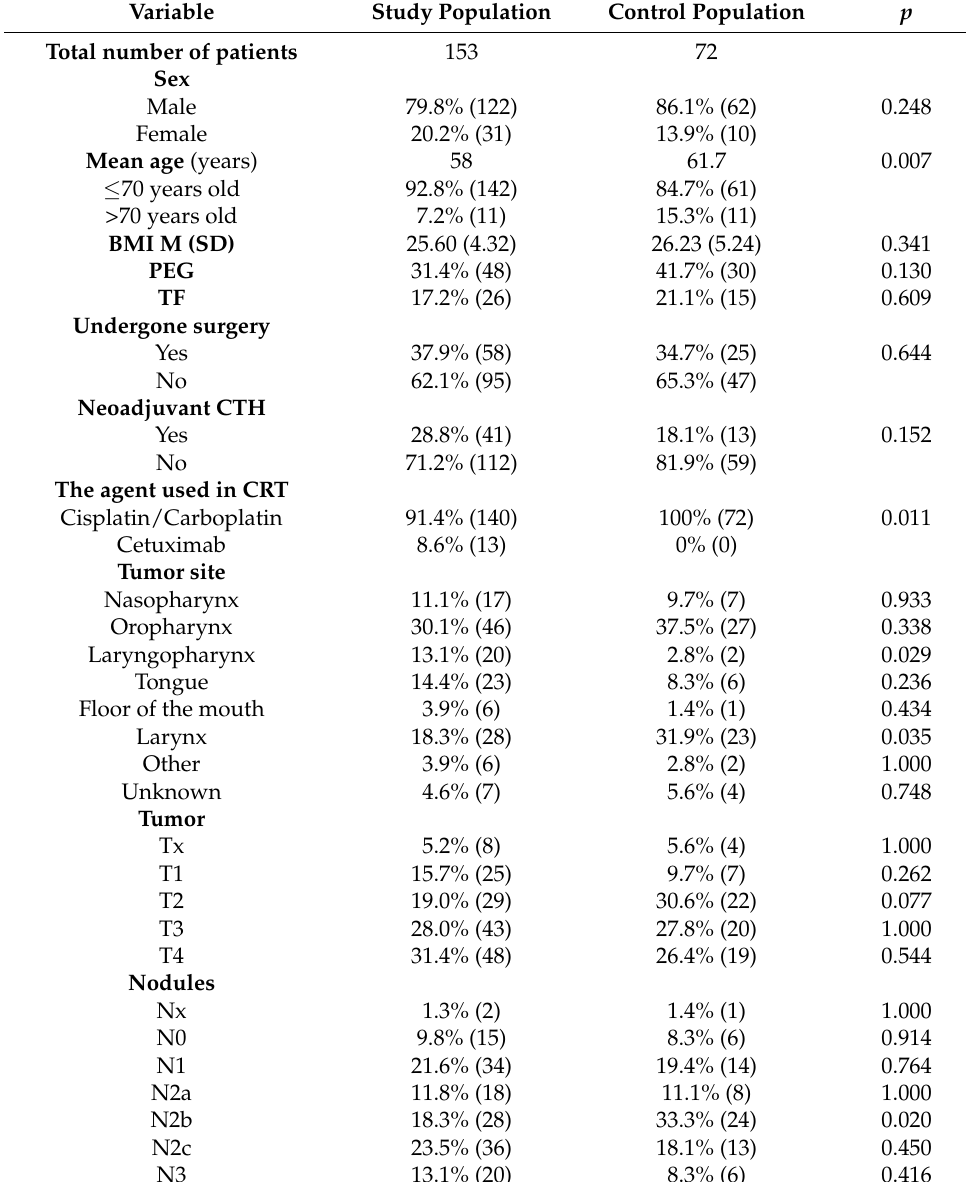
Table 1. Characteristics of populations ( n = 225). BMI: body mass index; PEG: percutaneous endoscopic gastrostomy, TF: tube feeding, CTH: chemotherapy, CRT: